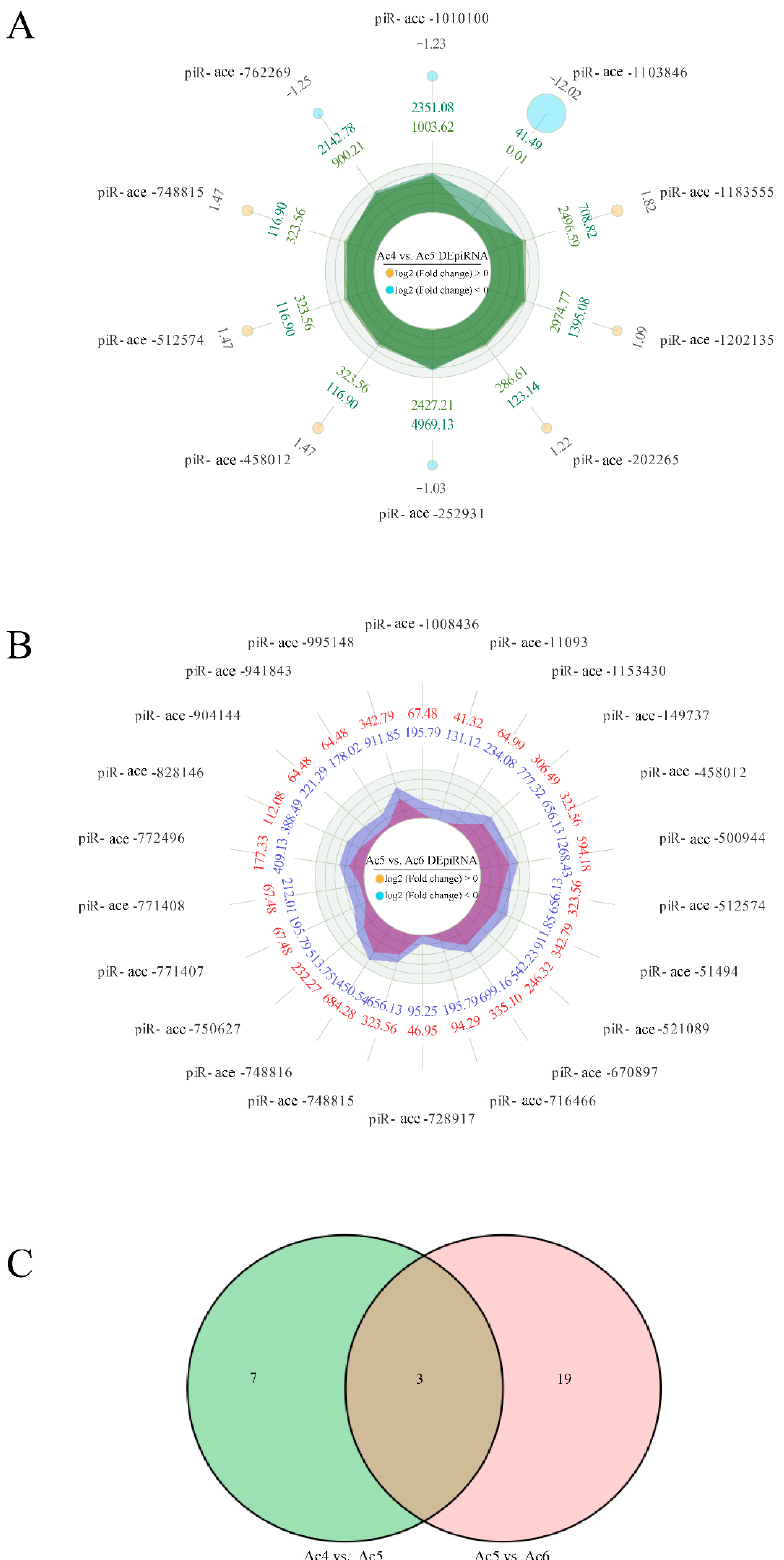
Figure 3. Radar maps and Venn diagram of DEpiRNAs. ( A ) Radar map of DEpiRNAs in the Ac4 vs. Ac5 comparison group. ( B ) Radar map of DEpiRNAs in the Ac5 vs. Ac6 comparison group. ( C ) Venn analysis of DEpiRNAs in Ac4 vs. Ac5 and Ac5 vs. Ac6 comparison groups. There were three up-regulated piRNAs that were shared by the above-mentioned two